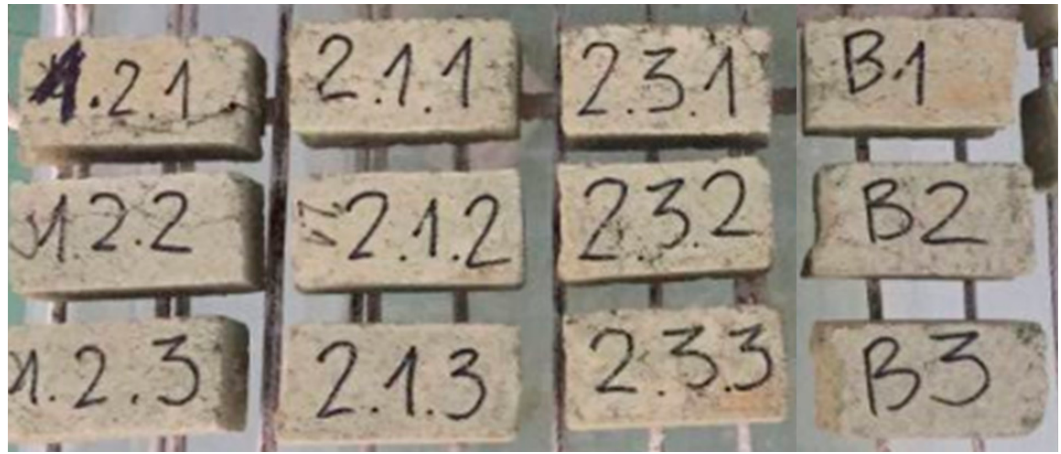
Figure 4. Glauconite clay mortar samples before the water immersion. From the left: CM-1, CM-2, CM-3, CM-0.